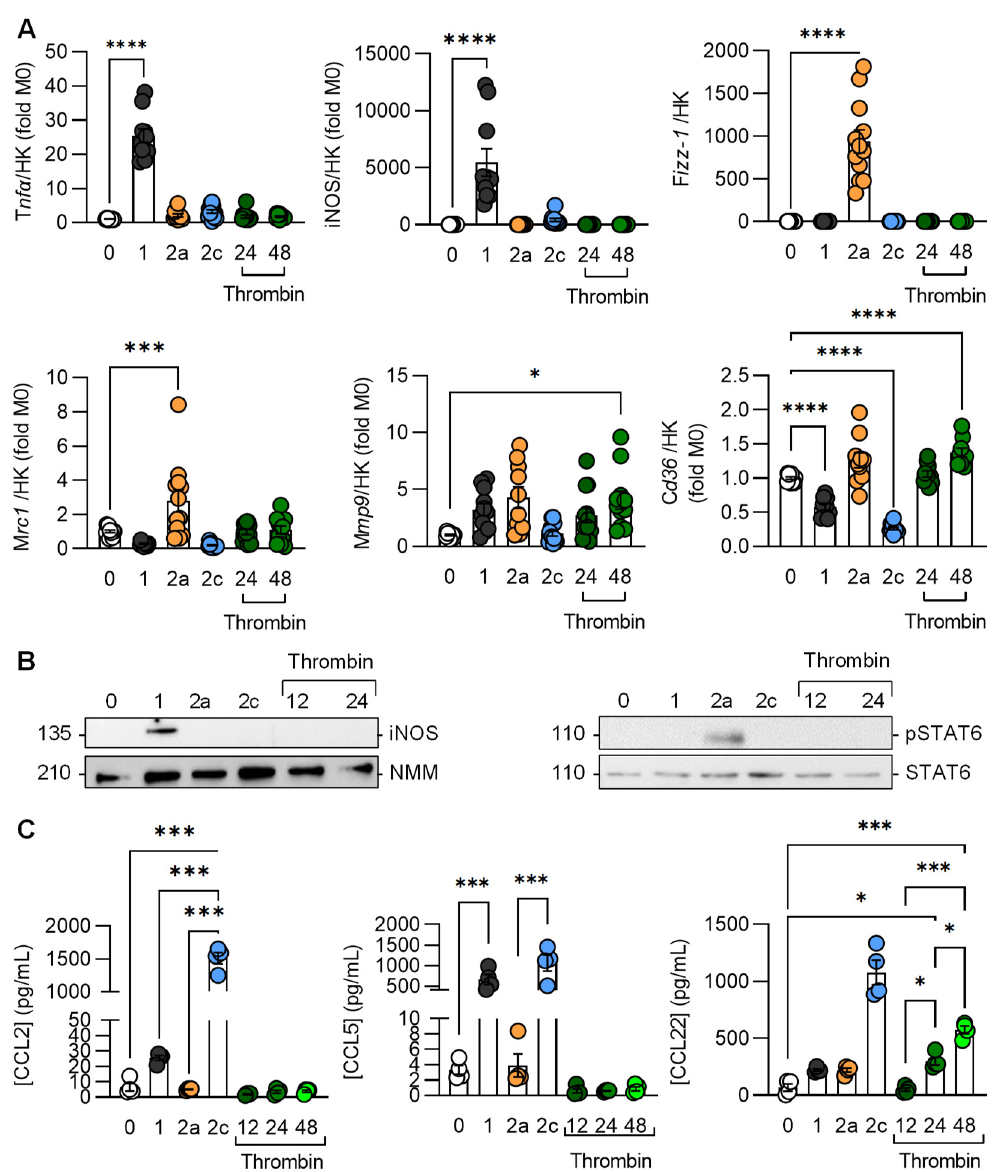
Figure 1. Effects of thrombin in murine macrophage chemokines. Murine bone-marrow-monocyte- derived macrophages were treated with either solvent (MØ) or with the combination of LPS (10 ng/mL) and INF- γ (1 ng/mL) for M1 polarization; IL-4 (20 ng/mL) for M2a polarization; and thrombin (1 U/mL) for 12, 24, and 48 h for Mth polarization. M1 macrophages were treated with TGF- β 1 (10 ng/mL) for 48 h for M2c polarization. ( A ) mRNA expression of macrophage phenotype markers with qPCR; n = 6 mice. HK = housekeeping genes. ( B ) Representative blots showing the expression of iNOS and the phosphorylation of STAT6 (pSTAT6) in differently polarized macrophages; n = 4 mice. NMM = non muscle myosin. ( C ) Cytokine levels in the macrophage supernatant; n = 4 mice. All experiments were performed at least twice. ( A , C ) One-way ANOVA followed by Tukey’s multiple comparison test. * p < 0.05, *** p < 0.001, **** p < 0.0001.